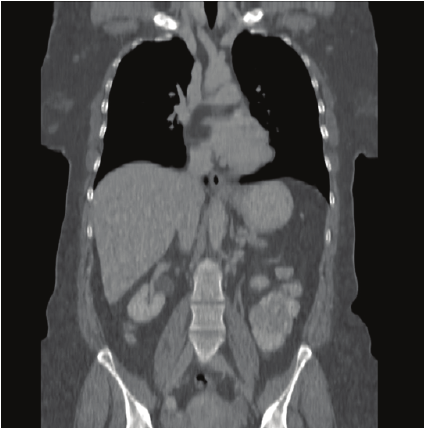
Figure 1: Axial CT image with intravenous contrast, showing the interatrial septal lipoma (encapsulated).